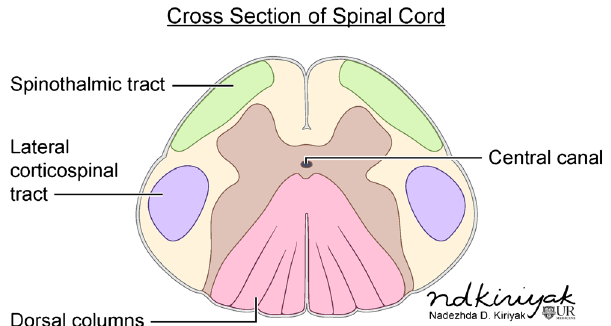
Fig. 1 Intramedullary spinal cord anatomy